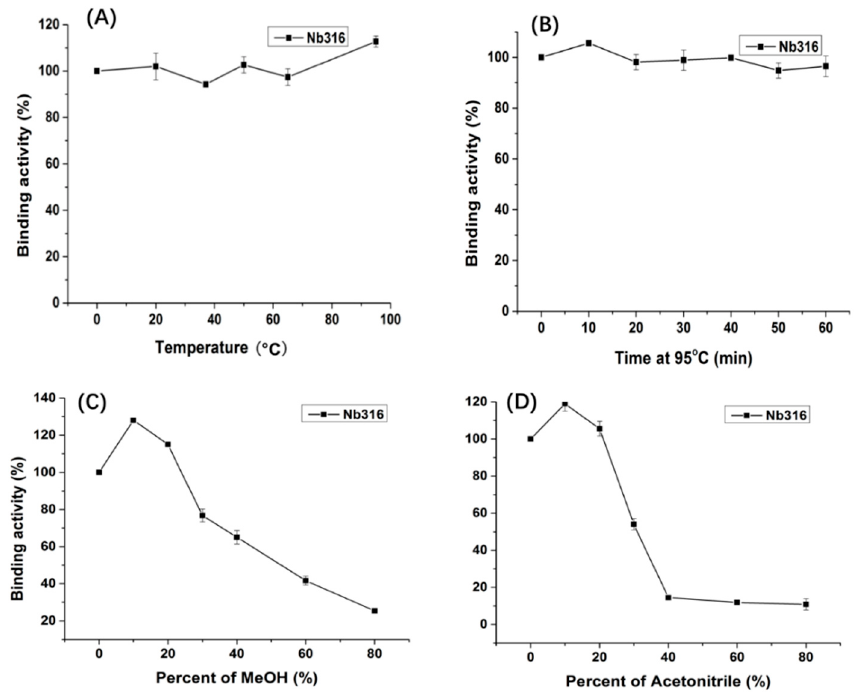
Figure 4. Thermostability and organic solvents tolerance of Nb316 by indirect ELISA based on the antigen BFNB-OVA and anti-HA-HRP antibody. ( A ) Nb316 (1 mg / mL) was incubated at 20, 35, 50, 65, 80, and 95 ◦ C for 5 min; ( B ) Nb316 (1 mg / mL) was incubated at 95 ◦ C for 10, 20, 30, 40, 50, and 60 min. A series concentration (10%, 20%, 40%, 60%, and 80%) of ( C ) MeOH and ( D ) acetonitrile was as the dilution reagents with Nb316.